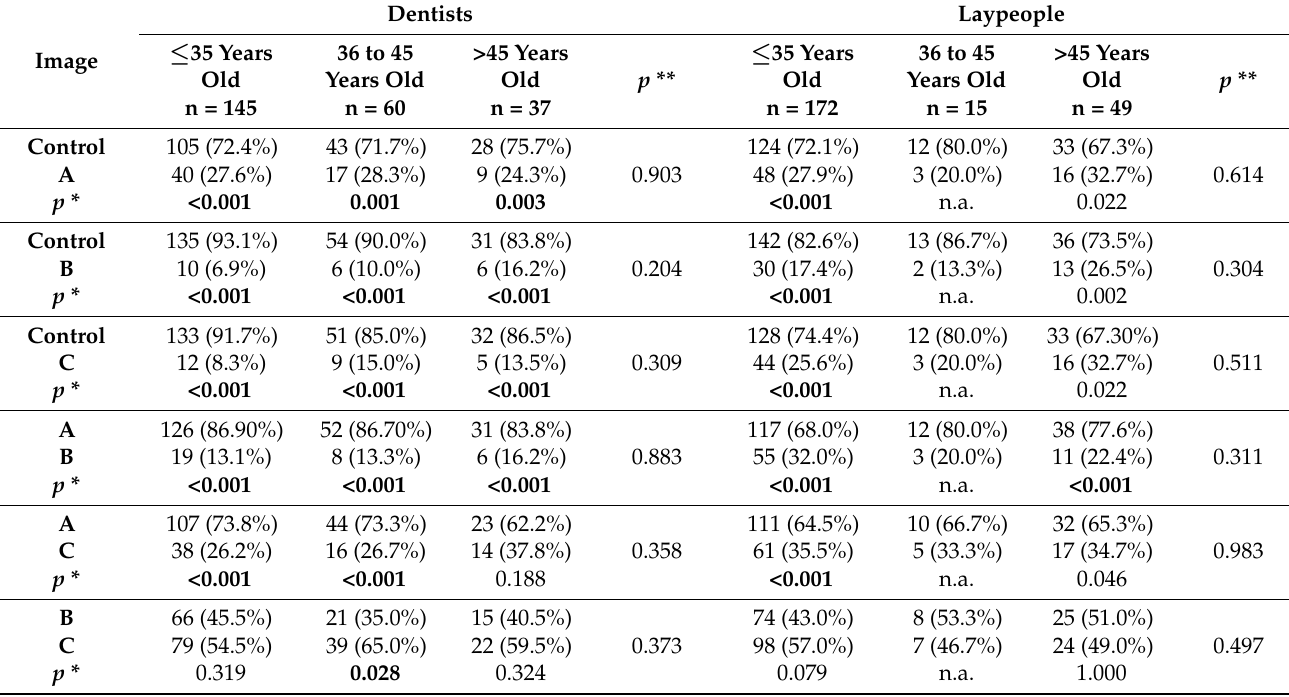
Table 3. Comparison of the perception of attractiveness in each group by age